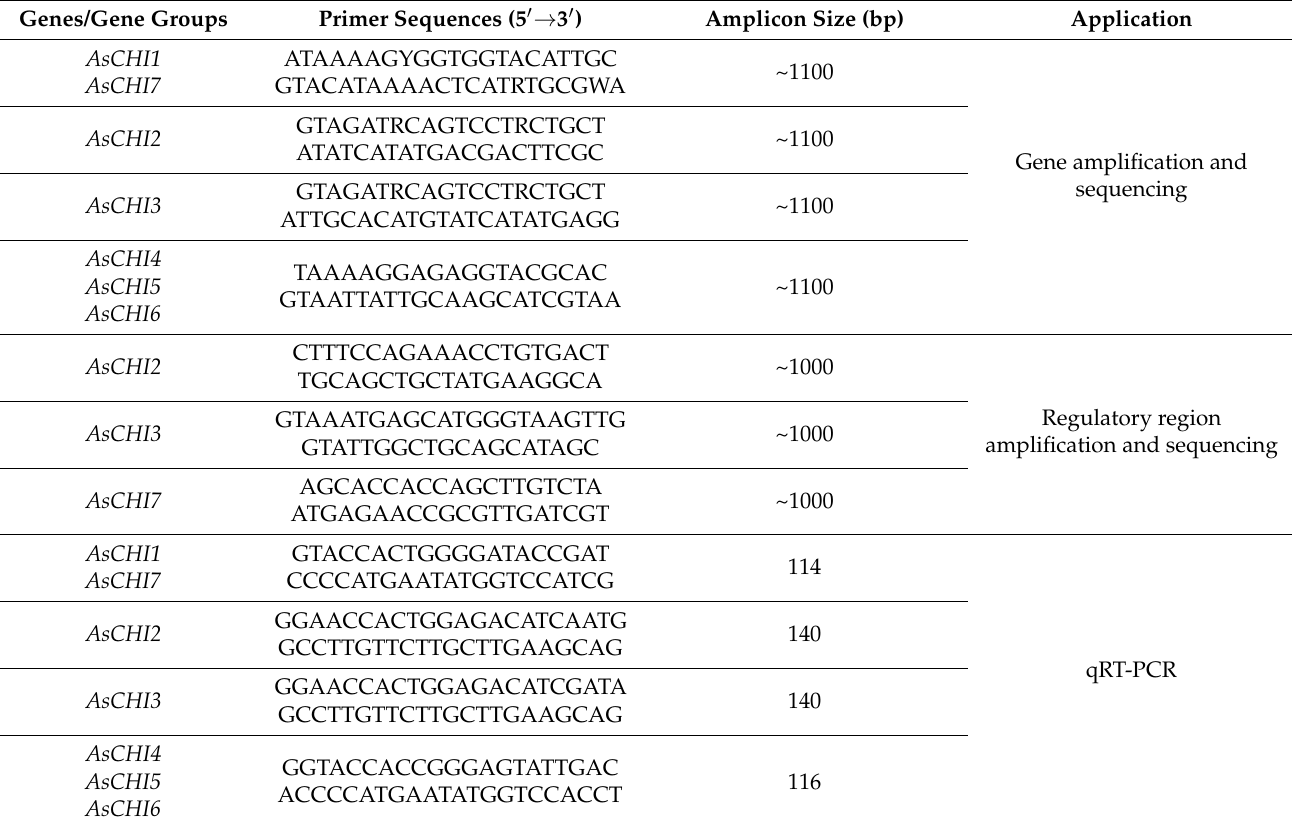
Table 5. List of primers for AsCHI1-7 gene amplification, sequencing, and expression analysis. Genes/Gene